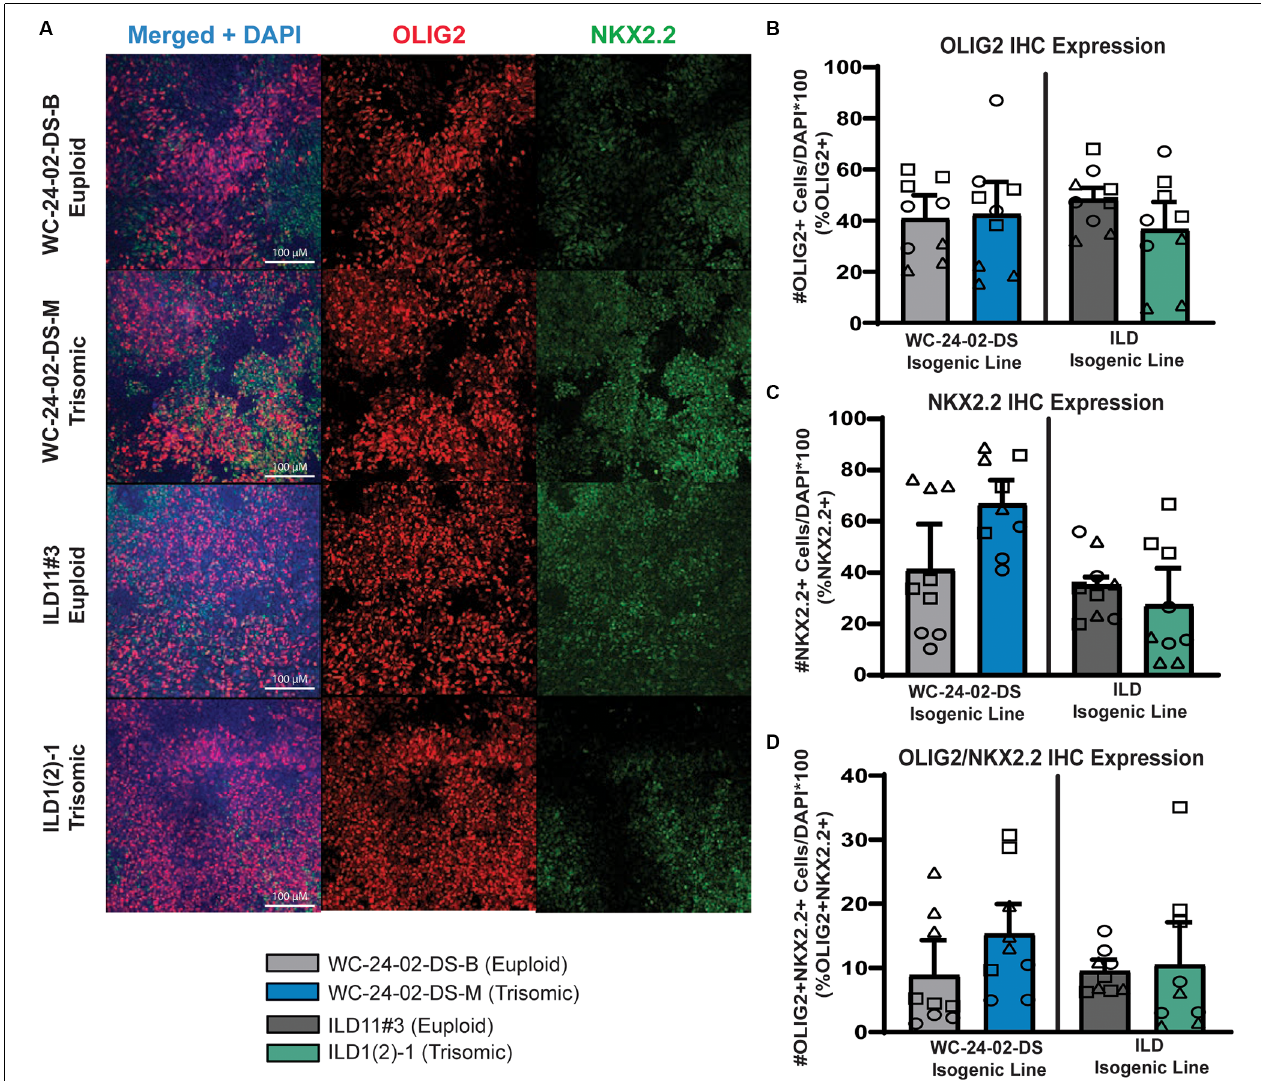
FIGURE 2 | Trisomic spinal-cord like NPCs show no difference in transcription factor expression during transition towards OL fate. (A) Both isogenic pairs of cells lines (WC-24-02-DS and ILD) differentiated with RA express OLIG2 and NKX2.2 in tNPCs after 4 days of treatment with SAG, an SHH pathway agonist. (B) In both isogenic pairs, there are no significant differences in OLIG2 expression in the trisomic line (WC ts and ILD ts ) compared to their euploid controls. (C) In both isogenic pairs, there is no significant difference in expression of NKX2.2 in the trisomic lines (WC ts and ILD ts ) compared to euploid. (D) There is no difference in the percentage of cells co-expressing OLIG2+ and NKX2.2+ between euploid and trisomic lines in either isogenic pair, n = 3, three independent differentiation experiments for all IHC measurements with values for individual wells (three per differentiation) overlaid. Data are shown as mean ±